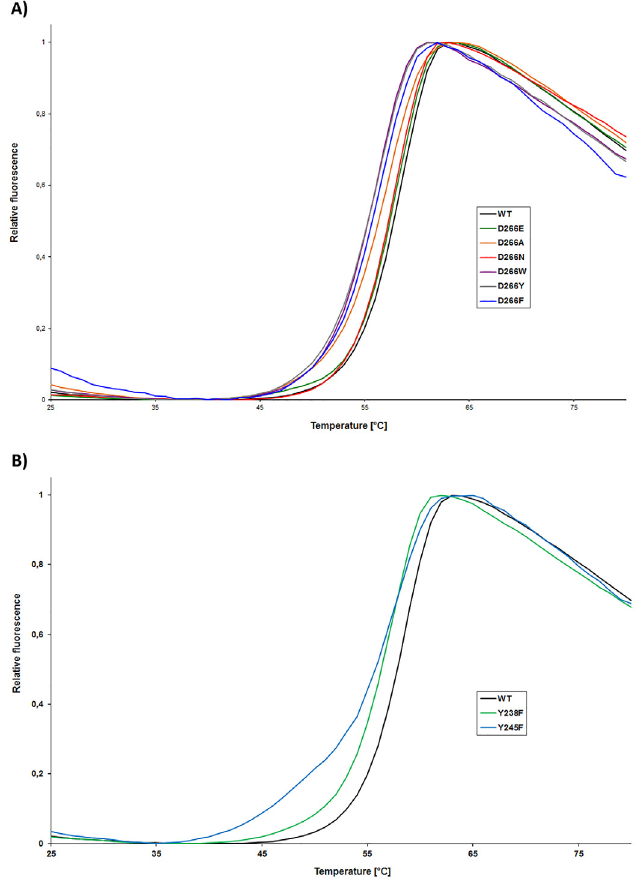
Fig 3. Tm curves of A) wild-type Sgf29 and its D266 variants and B) Sgf29 and its Y238 and Y245 variants. [a]